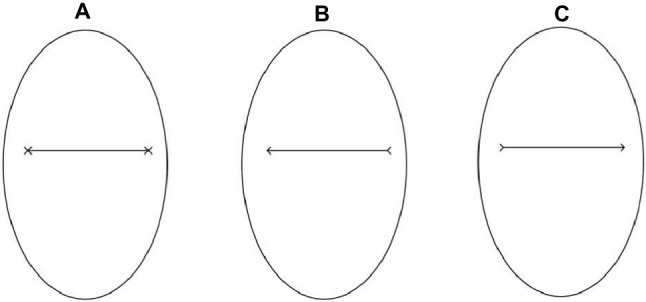
Example of a cue stimulus in Study 2: an oval framing a black segment with two Xs, at each end (A), a black arrow pointing either leftward (B) or rightward (C).